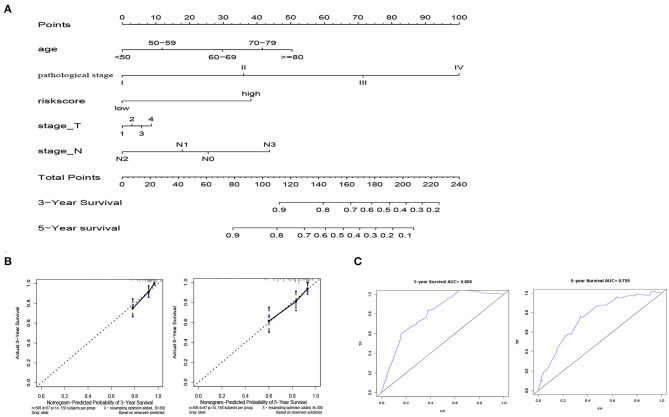
Establishment of nomogram model. (A) Normogram for predicting 3-year and 5-year OS in BRCA patients. (B)The calibration plots show that the nomogram has good predictability for the 3-year and 5-year OS of BRCA patients. (C) ROC curves of 3-year and 5-year OS prediction using the nomogram.